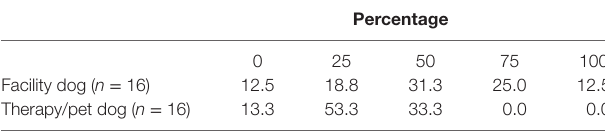
TaBle 3 | Percentage of interviews using facility or therapy/pet dogs.